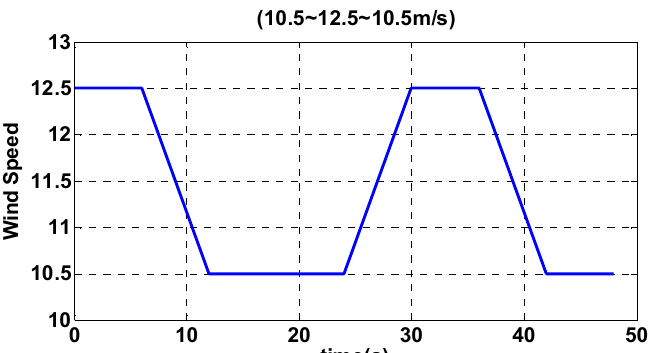
Figure 14. Changes within step input variable wind speed of 10.5–12.5 m/s.